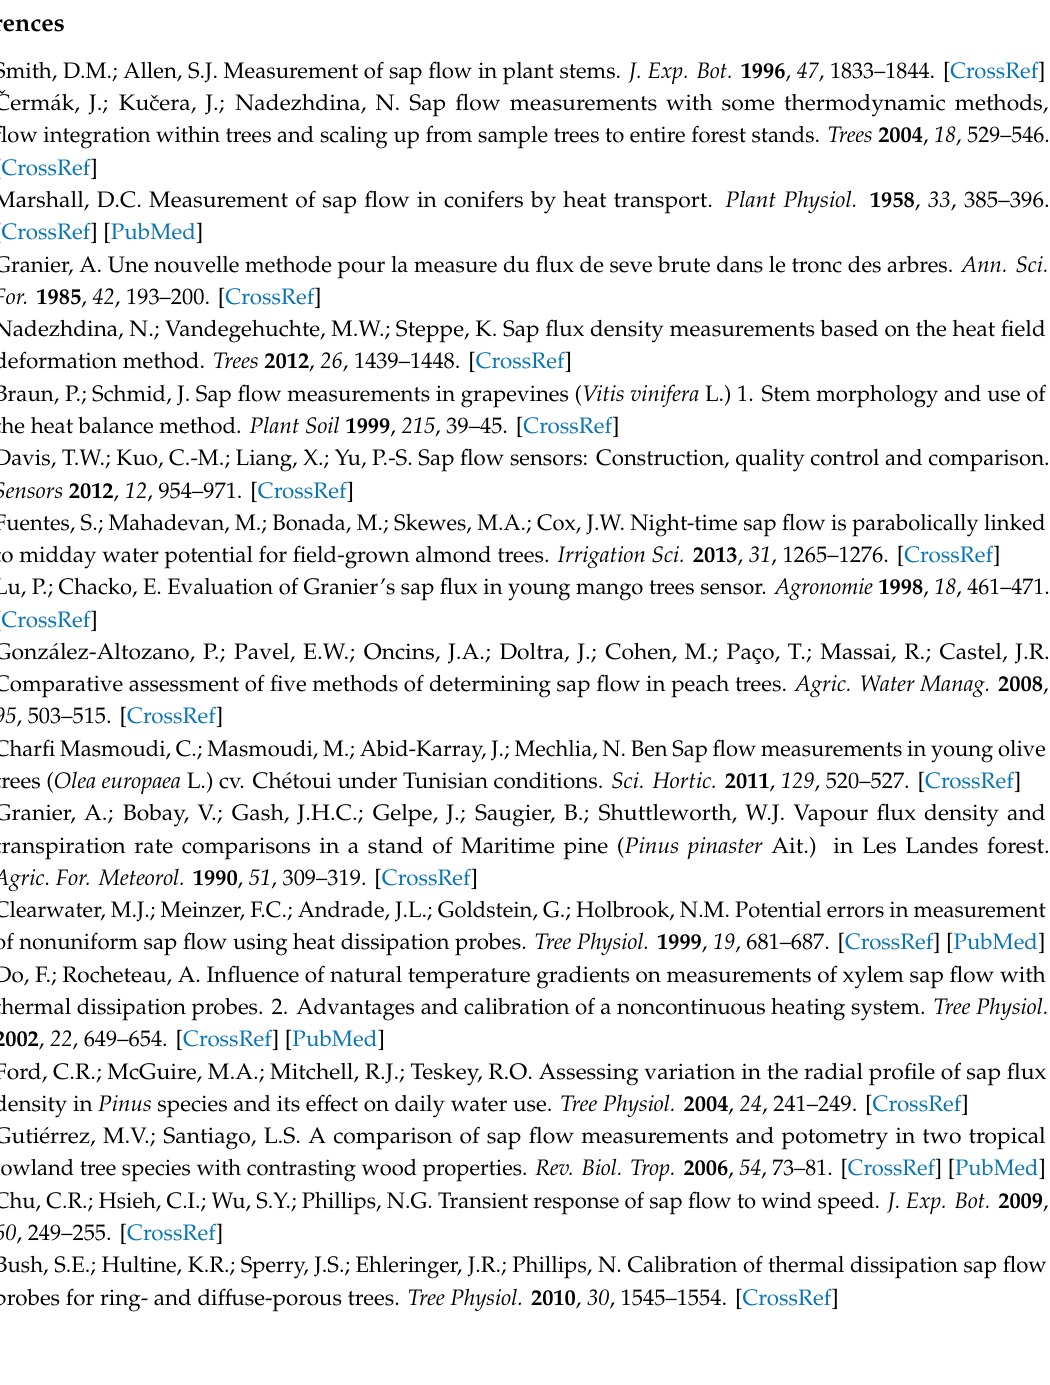
Figure S1: The accuracy expressed in percent is reported with the flow rate unit (dm 3 · dm − 2 · h − 2 ) for the sap flow meter Sensirion, mod. SLQ-QT500. The accuracy test on the sensor is provided by the producer of the sensor, while the figure and the scale were adapted to our case